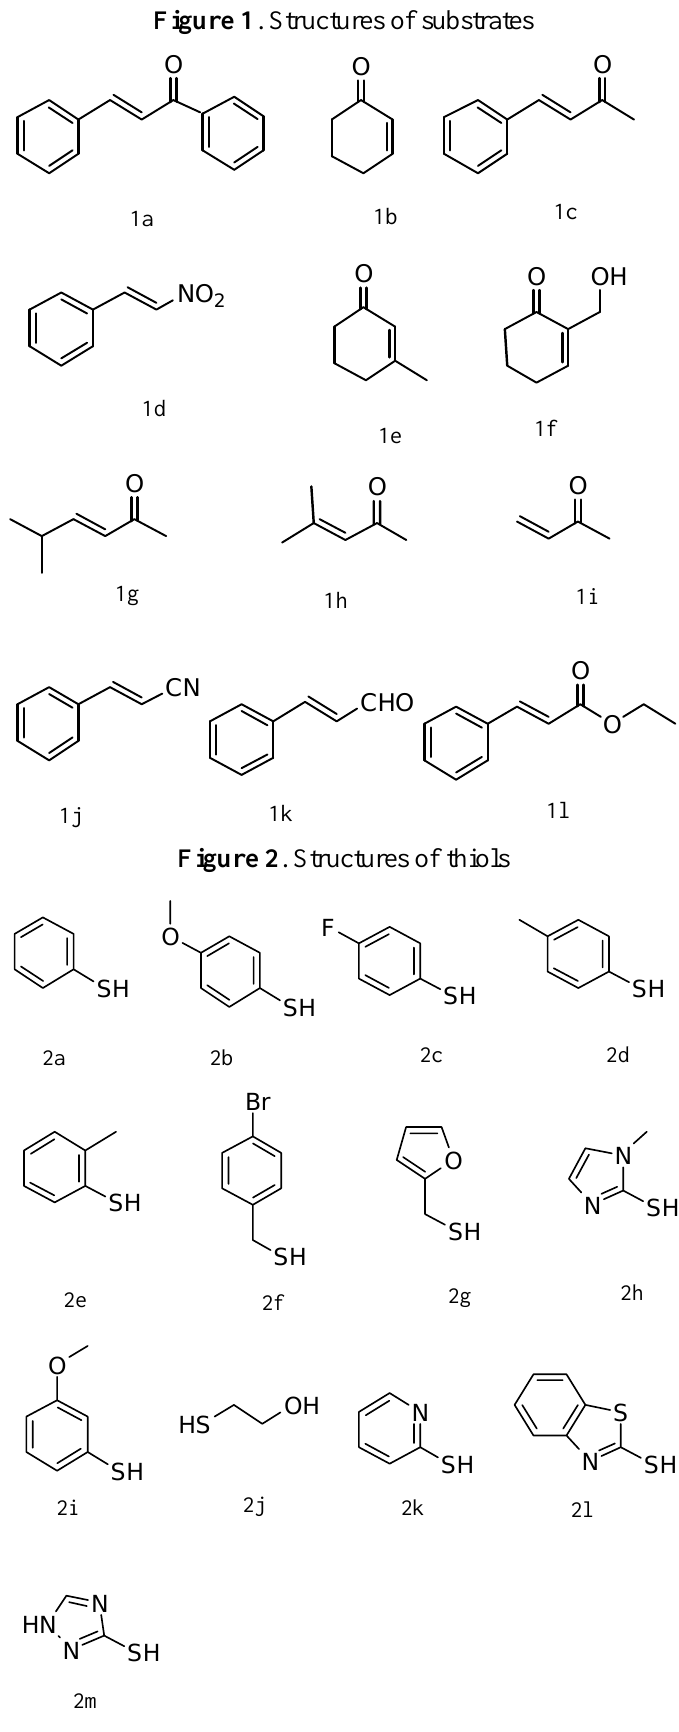
Figure 1 . Structures of substrates